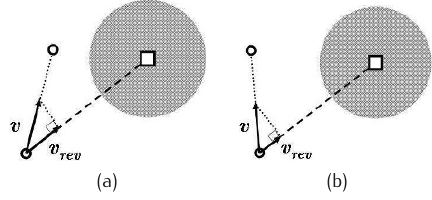
Figure 4. The search algorithm relocates the via points for changing the relative velocity between the robot and the obstacle.